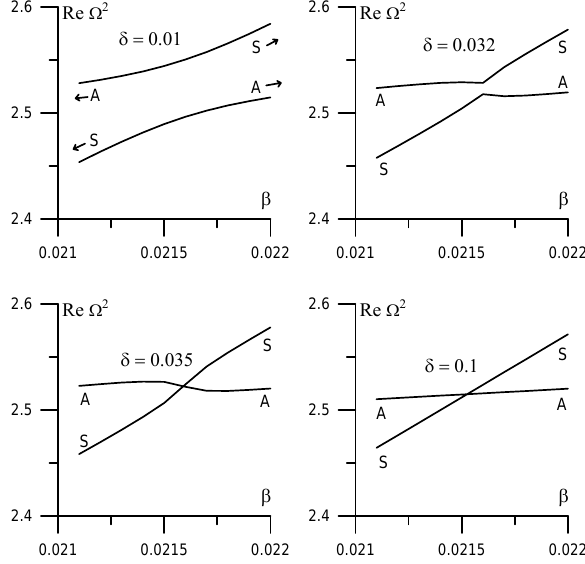
Fig. 8c. Growth rate spectrum for δ = 10 (local midnight). Flute mode F (3.5) becomes unstable right after ballooning mode B splits. Flute mode F+ (4.2) is always unstable.